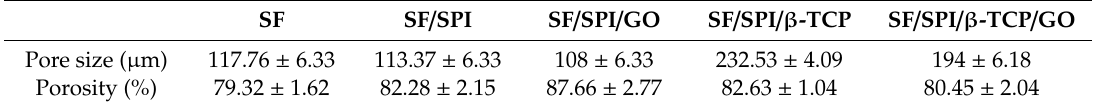
Table 2. The pore size and porosity of SF-based composite sca ff